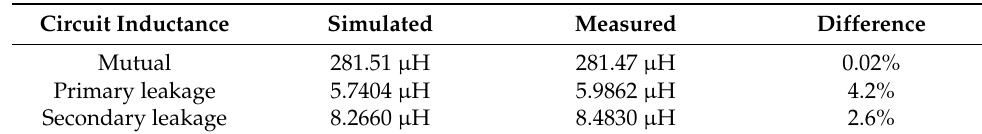
Table 10. Comparison between simulated and measured circuit inductances of separate-winding prototype HF transformer.